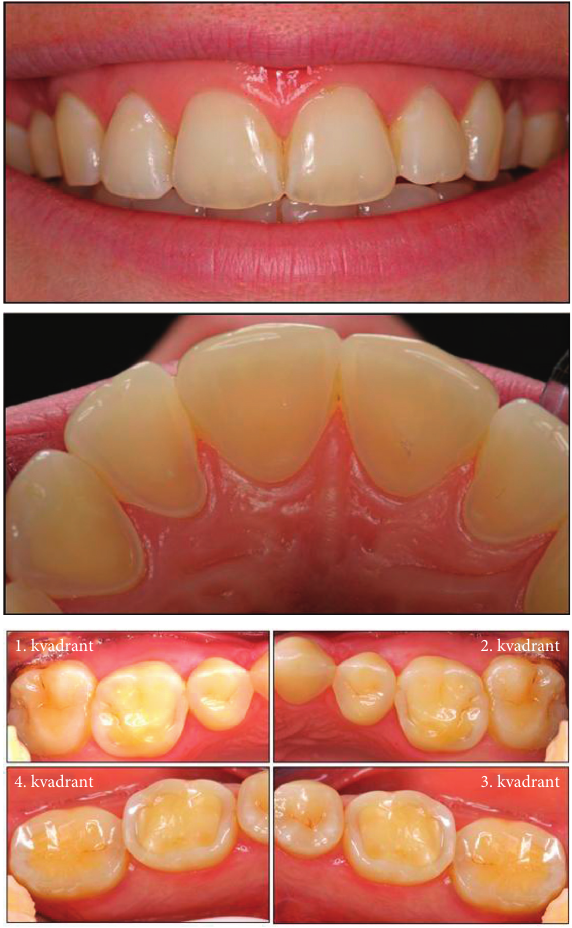
Figure 1: Clinical case one (Mulic et al., 2012 and Mulic et al.,